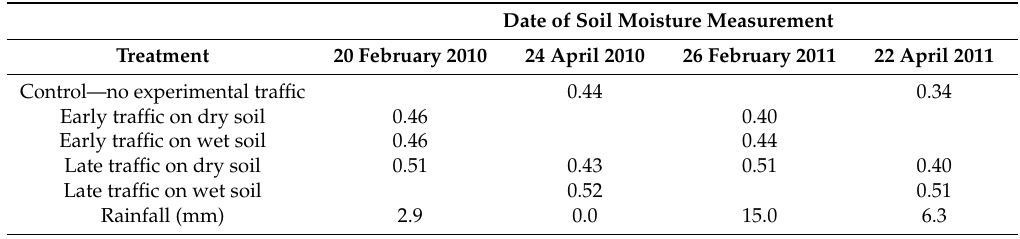
Table 4. Volumetric soil moisture content (%) to 0.12 m depth, on the days that treatments were applied in 2010 and 2011. Rainfall (mm) in the week preceding each treatment date is also